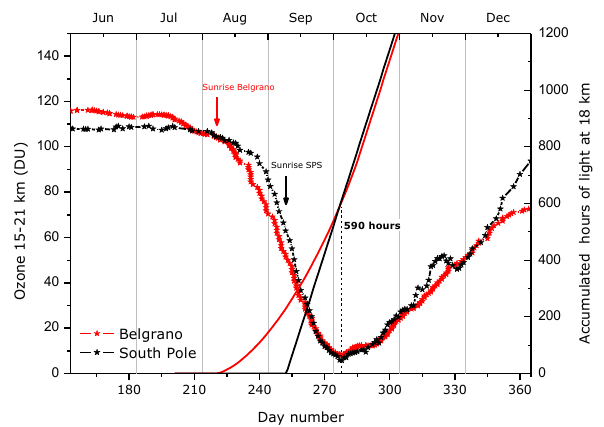
Fig. 9. Mean values from years 1999–2009 of the ozone partial col- umn for the 15–21km layer (left scale) for Belgrano (red stars) and Figure 9. 1999-2009 mean values of the ozone partial column for the 15-21 km layer (left 4 SPS (black stars). Solid lines represent the accumulated hours of scale) for Belgrano (red stars) and SPS (black diamonds). Solid lines represent the 5 light for both stations (same colour code, scale at the right side). accumulated hours of light for both stations (same colour code, scale at the right side). 6